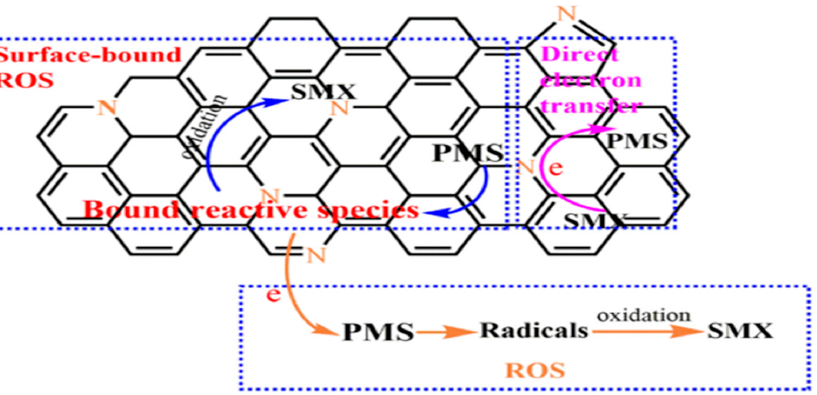
Figure 3. Proposed mechanism of PMS catalytic process by N‑doped sludge‑derived biochar [67], copyright 2021, Elsevier.